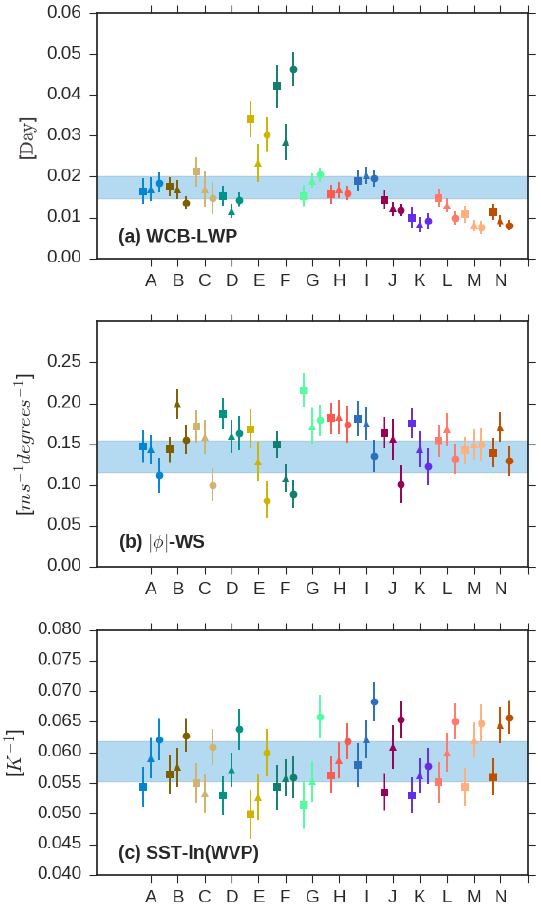
Figure 3. The slope of the best fit line between monthly- and regional-mean anomalies of different cyclone-mean properties. Symbols denote different SH ocean basins (South Atlantic: squares, South Indian: triangles, and South Pacific: circles). Model colors are as in Fig. 1. Each model is labeled with a letter on the ordinate (see Table 2). The observations are shown as “A”. The 95% confi- dence on the slope is noted for each basin. The shaded area shows the 95% confidence on the mean of the observed slope based on the SH ocean basins. Panel (a) shows the slope of the regression of cyclone LWP RM on WCB moisture flux, panel (b) shows the regres- sion slope of the mean wind speed in cyclones on mean poleward latitude, and panel (c) shows the regression slope of ln(WVP) RM on SST RM